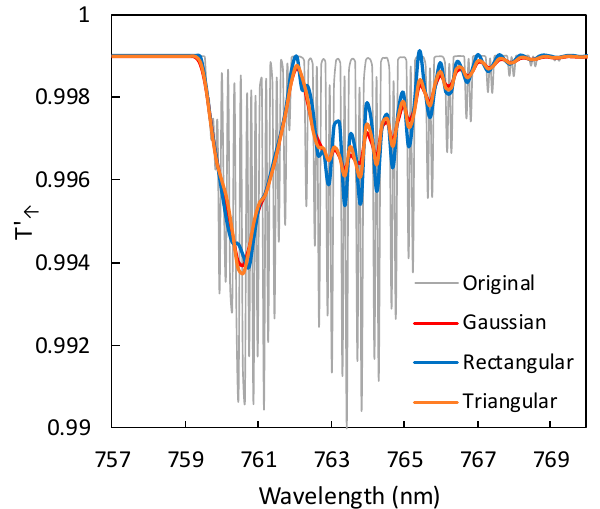
Figure 9. MODTRAN simulated up-welling transmittance convolved with Gaussian, Rectangular and Triangular instrument spectral response function (ISRF) with a full-width at half maximum (FWHM) of 0.31 nm and resampled with spectral interval of 0.155 nm. The FWHM of the original simulation (grey line) is 1 cm − 1 (~0.06 nm at 760 nm), the sensor height is 25 m, the surface elevation is 1.5 km, the view zenith angle (VZA) is 25°, and the AOD 550 is 0.1.